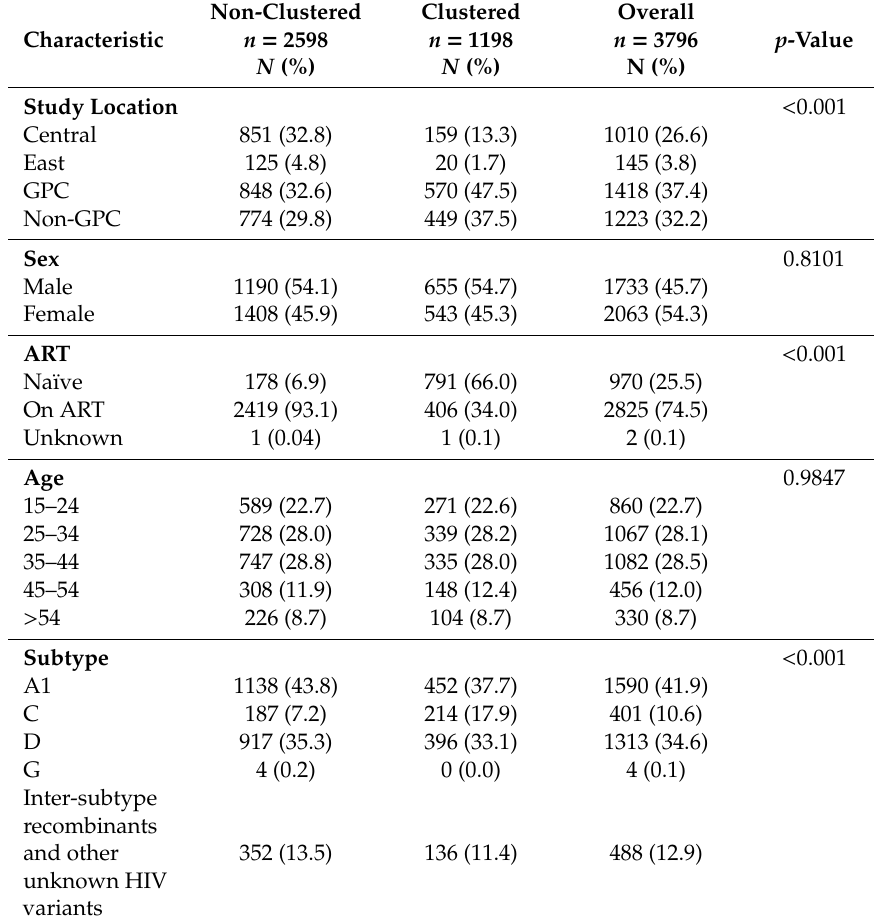
Table 1. Demographic and Clinical Characteristics of Study Population.